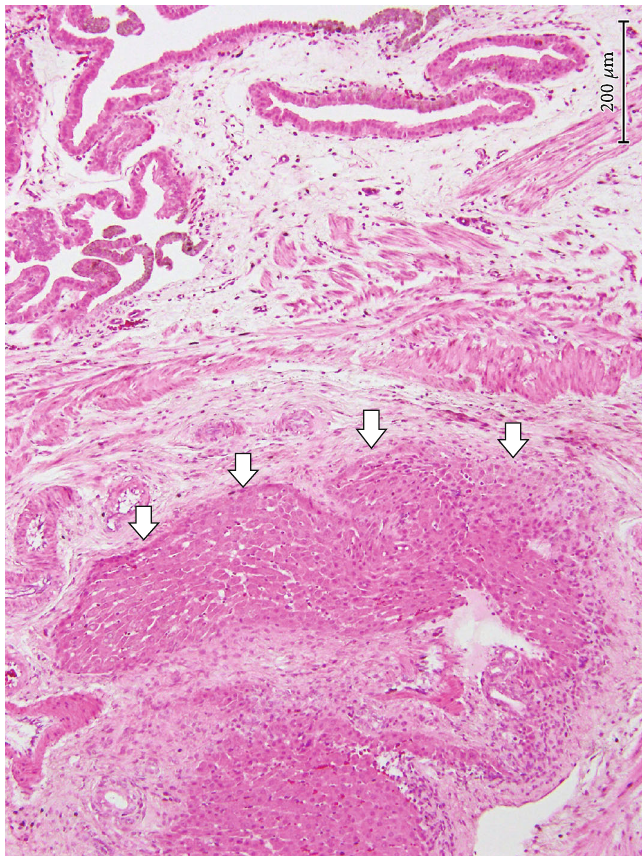
Figure 1: Microscopic fi nding of ectopic hepatic tissue. Microectopic hepatic tissue (arrowheads) was found beneath the lamina propria mucosae of the normal gallbladder, intermingled with the muscular fi bers of the muscularis. HE stain. × 100, bar = 200 μ m